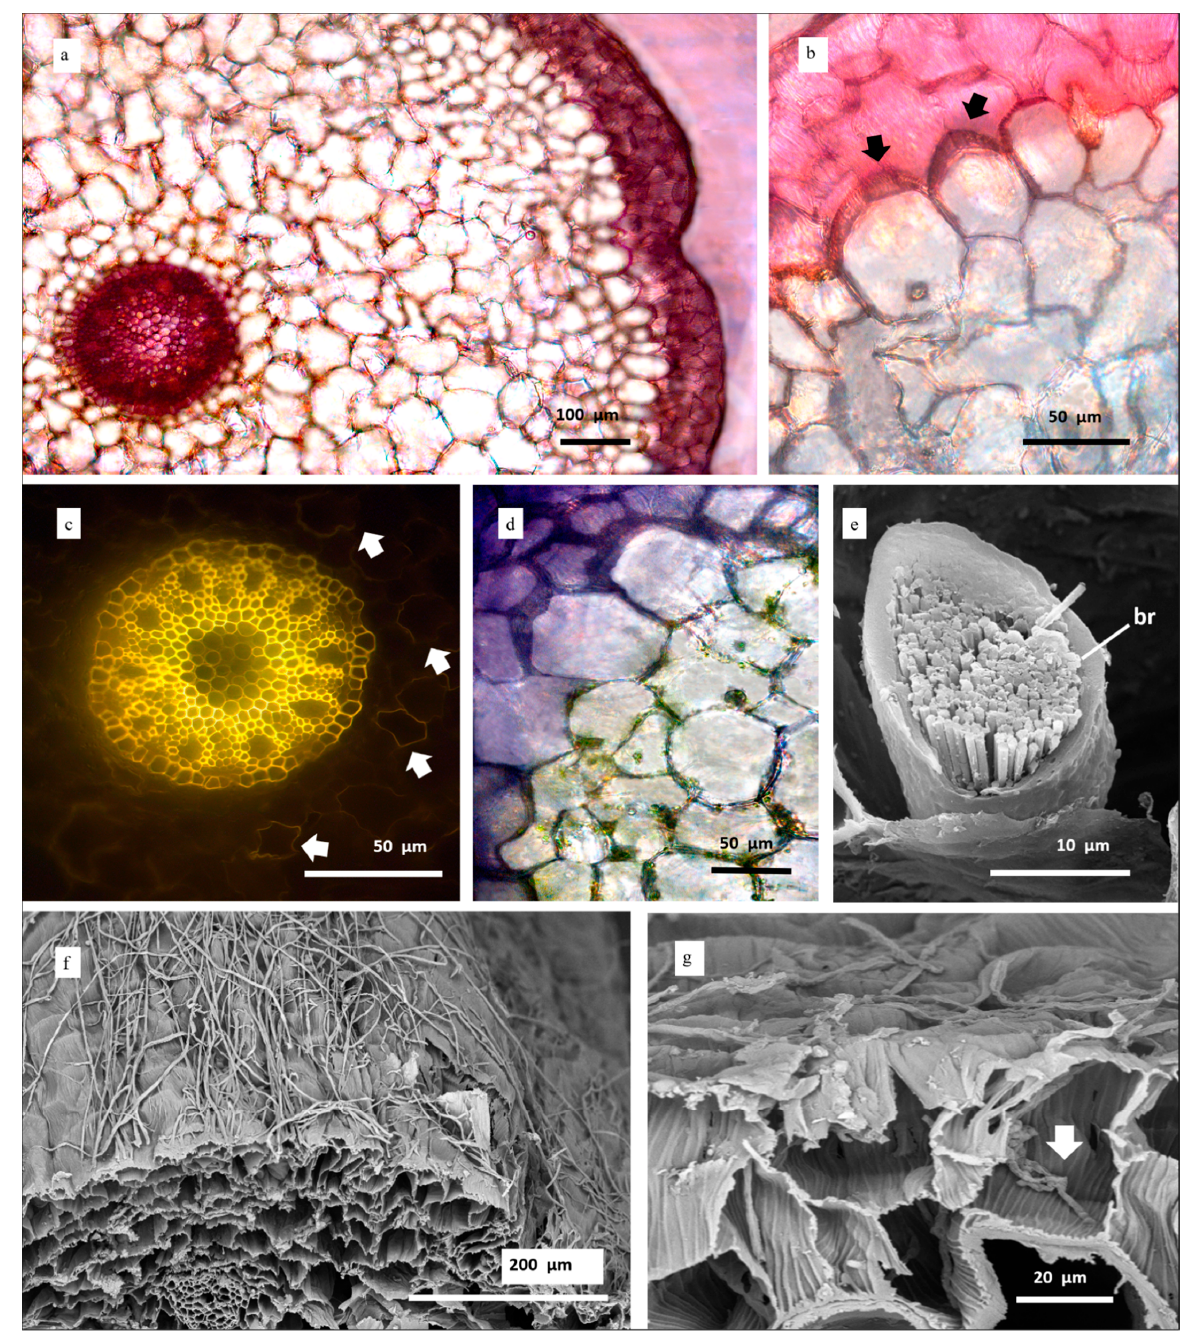
Figure 3. Root anatomy of Cattleya purpurata seedlings. Representative seedlings obtained on 1/2MS were selected for panels ( a – e ) and from OA medium for panels ( f , g ). ( a ) overview of the root’s transversal section stained with Phloroglucinol-HCl. Velamen is composed by a 2–3 cells wide layer; exoderm cells appear large, polygonal, and ∩ -thickened; cortex cells from middle layers are larger than those near to the exoderm and to the endoderm. The vascular cylinder is composed by a polyarch actynostele; ( b ) tufted tilosomes (arrows) observed in the endovelamen-exoderm region; ( c ) Fluorol Yellow staining: detail of the central vascular cylinder characterized by a polyarch actinostele. The central parenchymatic tissue is composed by circular cells alternating with lignified elements. Cortex elements showing suberized cell walls are also visible (arrows); ( d ) chloroplasts within cortex cells; ( e ) SEM photograph of bundledraphides (br) within a cell of cortical parenchyma; ( f ) SEM image of mycorrhizal hyphae in the first stages of colonization of a root obtained from symbiotic culture; ( g ) the beginning of hyphal coiling inside a velamen cell (arrow). Banded wall thickenings of velamen cells are also